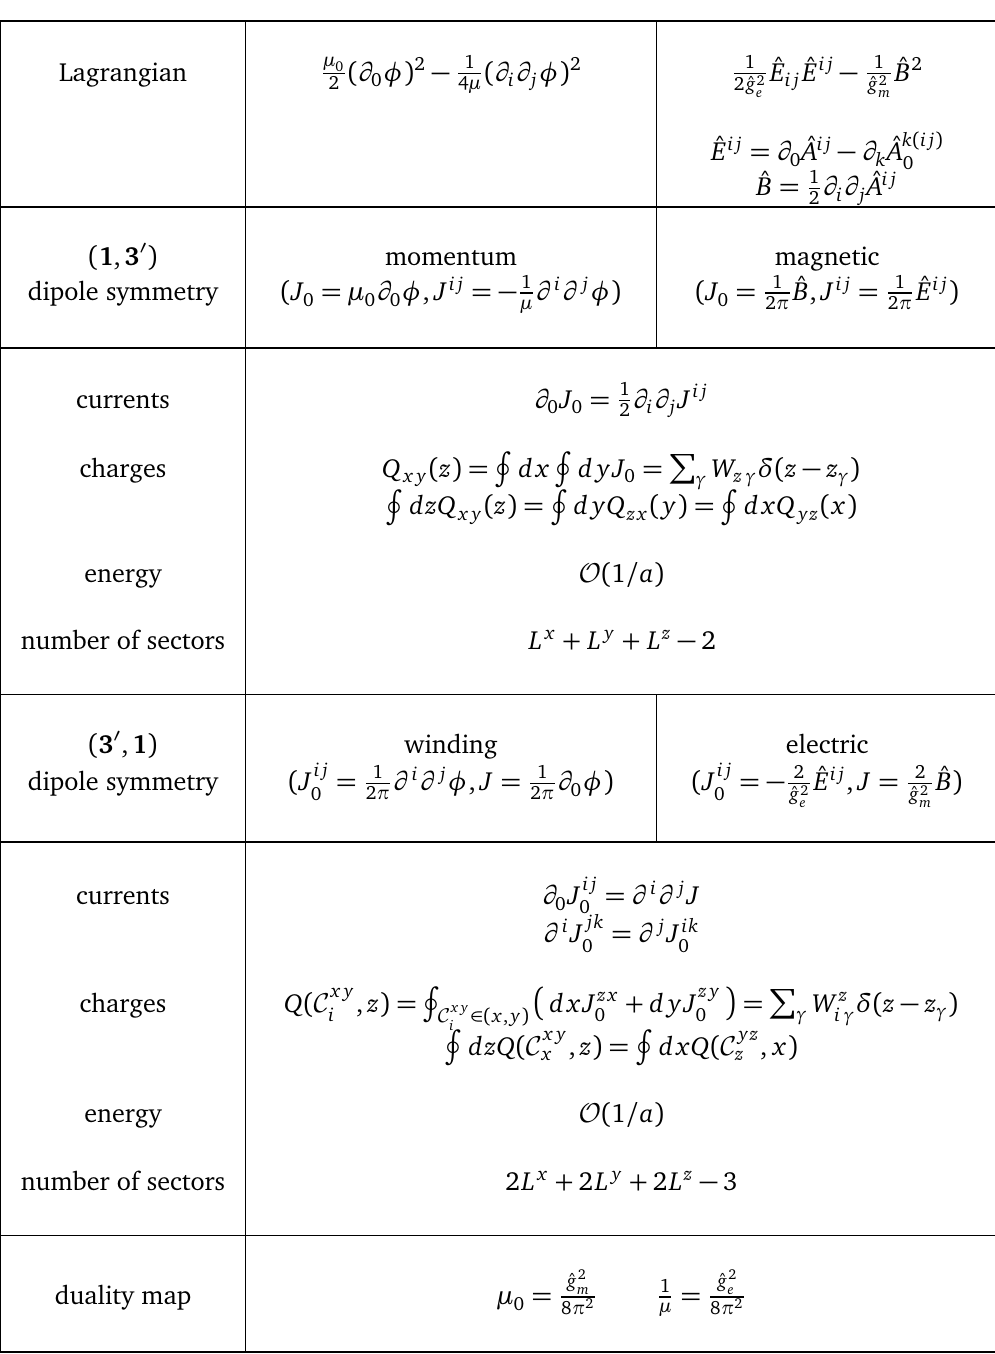
Table 2: Global symmetries of the U ( 1 ) tensor gauge theory ˆ A and its dual φ . Here C ij is a curve on the i j plane that wraps around the i cycle once but not the j cy- i cle. Above we have only shown charges for some directions, while the others admit similar expressions. See [ 2 ] for more